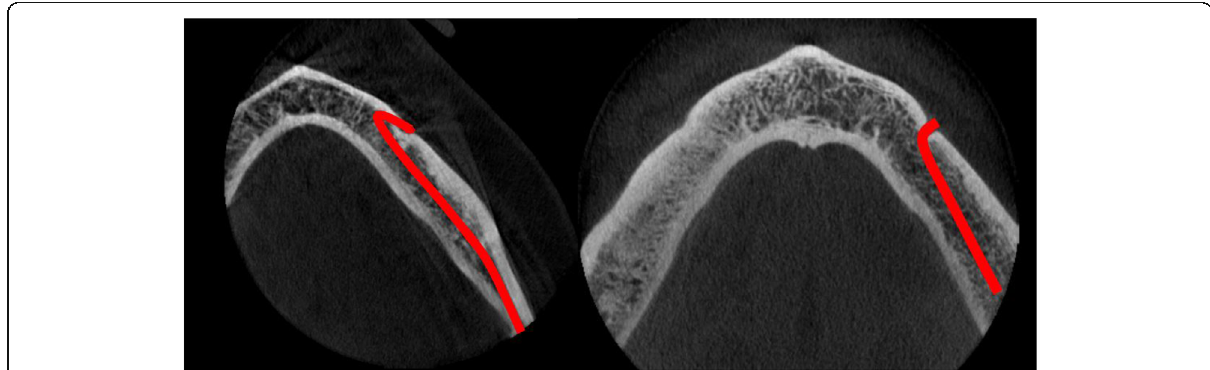
Fig. 1 Modified axial images showing presence of anterior loop (left) and absence of anterior loop